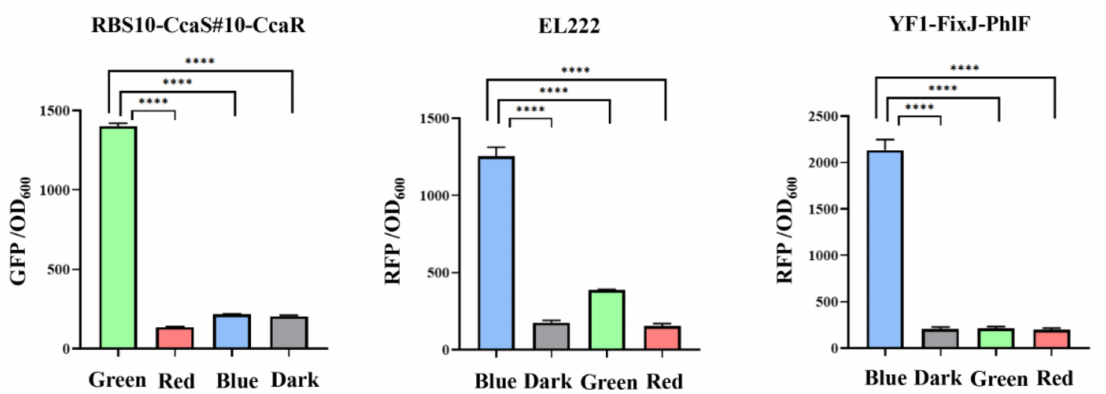
Figure 3. Analysis of the crosstalk of light-based systems under different lights. RBS10–CcaS#10– CcaR, EL222, and YF1–FixJ–PhlF were characterized with GFP or RFP to OD600 under single green, red, or blue lights or dark conditions. All results were calculated with three ( n = 3) independent replications. Error bars represent means ± standard errors of the mean (SEMs). **** p <